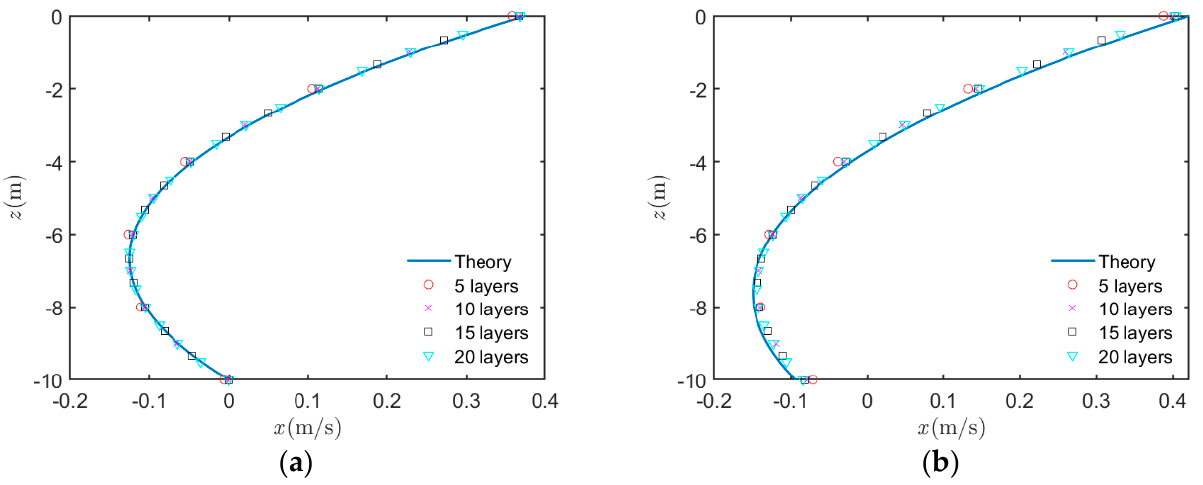
Figure 5. Comparison between the numerical results and the analytical solution for the vertical distribution of horizontal velocity at the center of the basin. ( a ) Homogeneous Dirichlet boundary condition; ( b ) Neumann boundary condition.